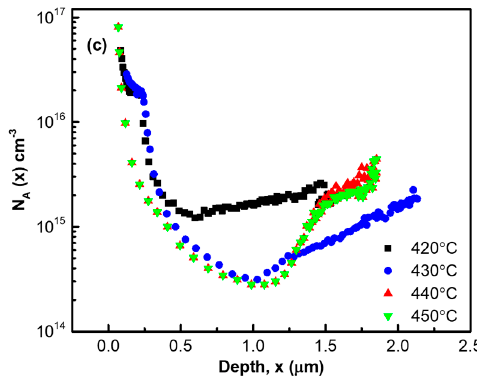
Figure 5. ( a ) Illuminated J-V curves ( b ) EQE spectra and ( c ) acceptor concentration profiles of ZnTe:As back contacted devices annealed at 420, 430, 440, and 450 °C for 10 minutes each.